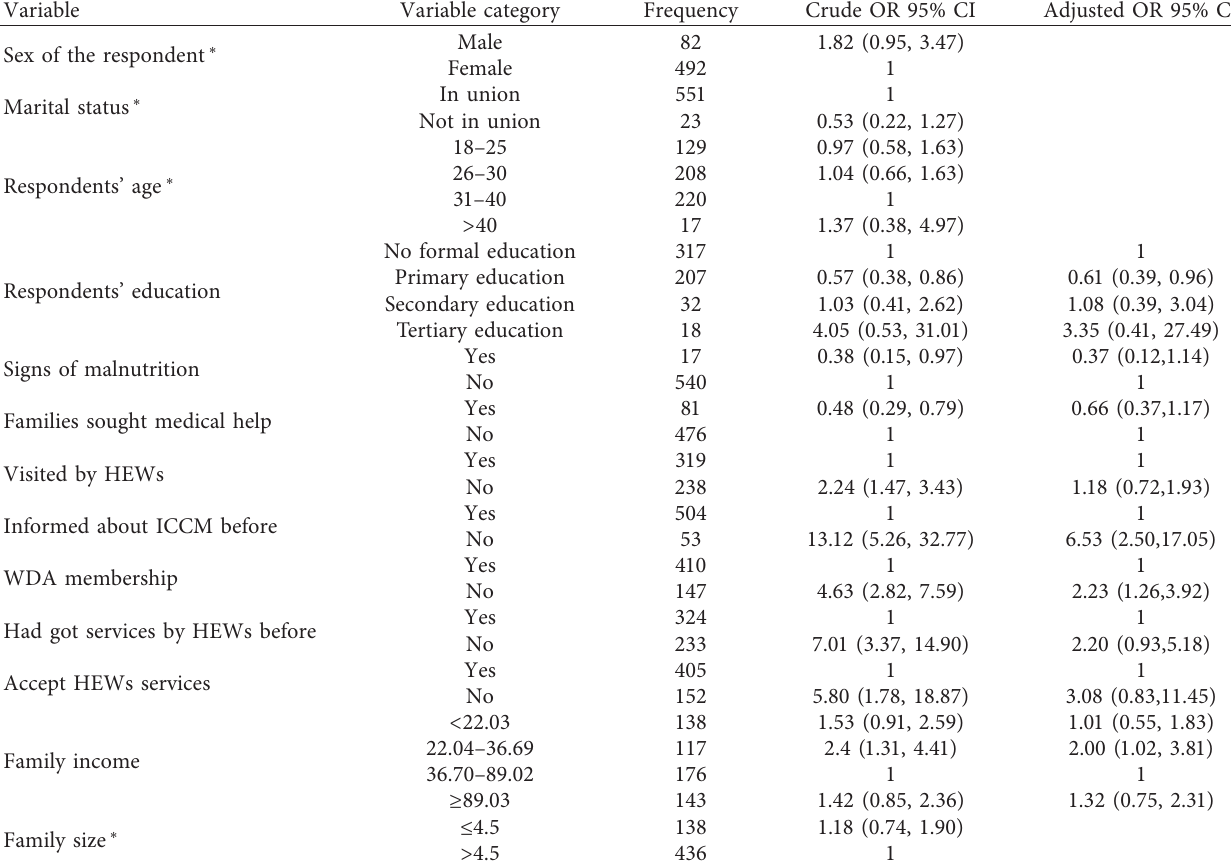
Table 3: Factors associated with ICCM service utilization in Hadiya Zone, Ethiopia, June